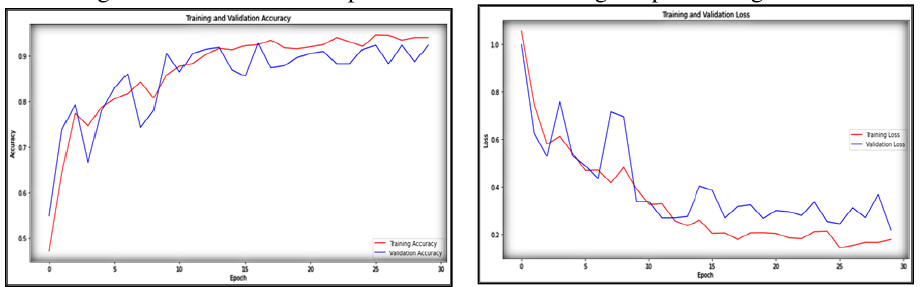
Fig. 3. Training and validation accuracy for the Fig. 4. Training and validation loss for the weather classification